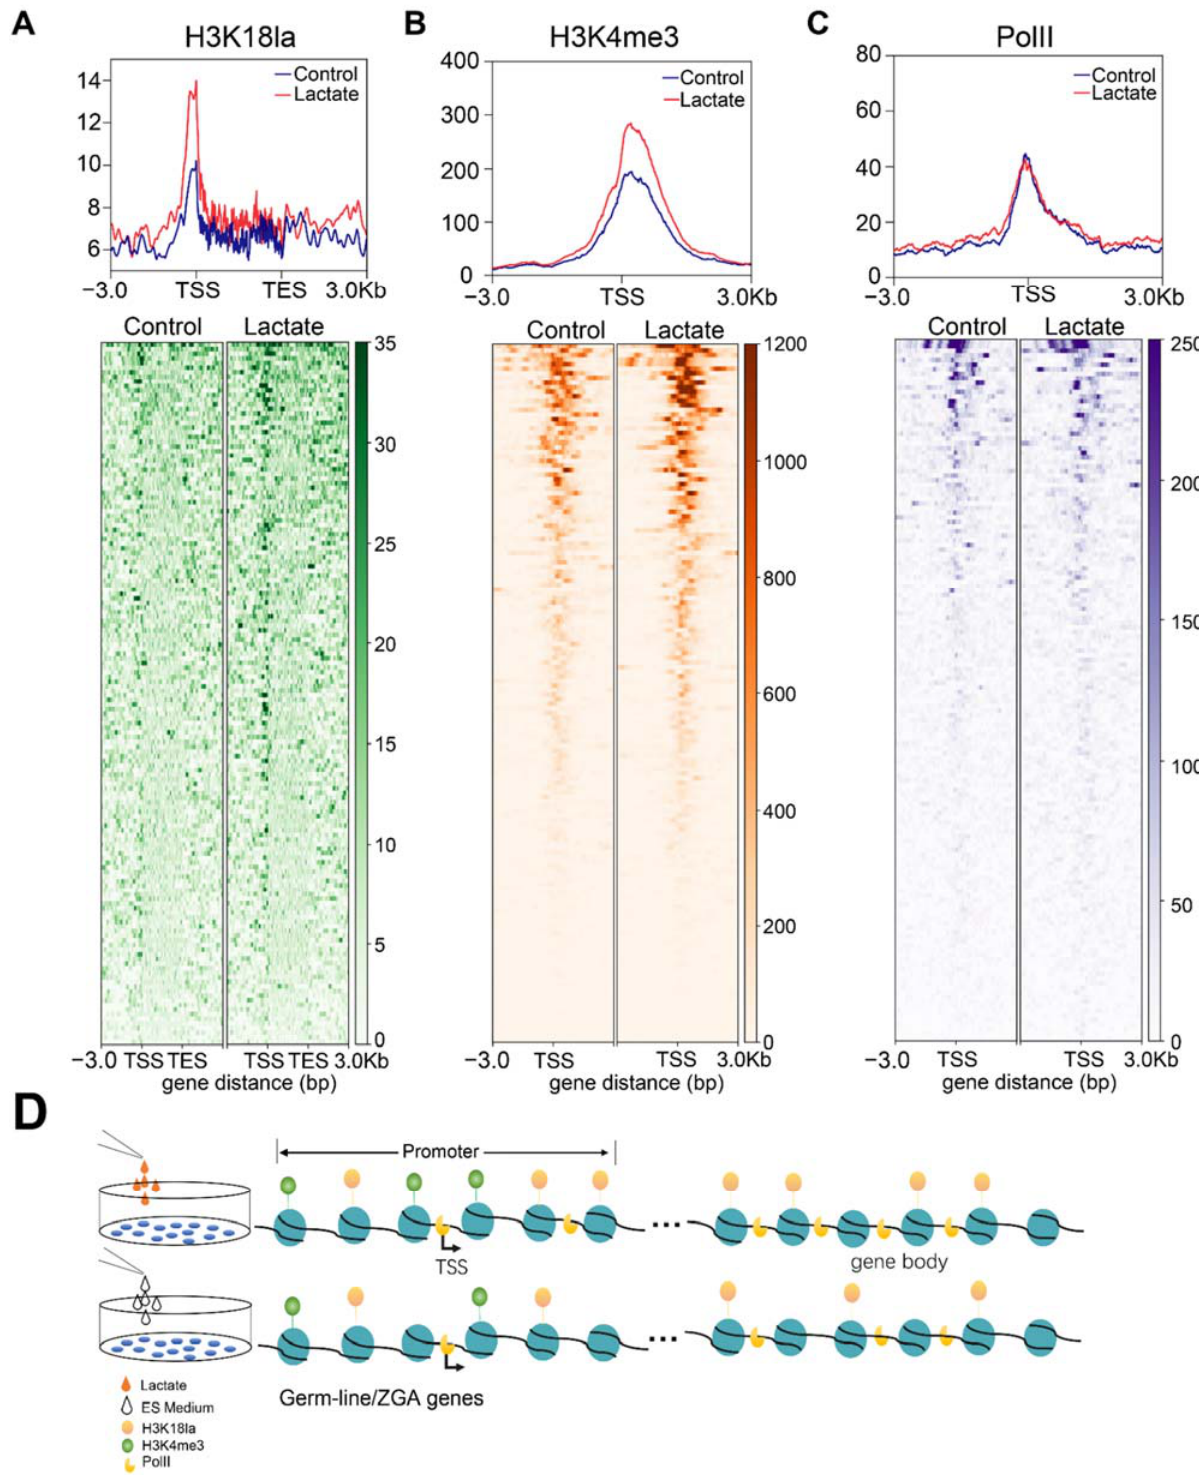
Figure 5. Lactate supplementation facilitated transcriptional elongation through enhanced histone lactylation. ( A – C ) Read density plot of H3K18la ( A ), H3K4me3 ( B ), and RNA PolII ( C ) signals at gene bodies and promoters of upregulated genes ( upper panel ), and corresponding heatmap at gene bodies and promoters (3 kb flanking TSSs) of upregulated genes ( lower panel ). ( D ) Schematic diagram of the mechanism by which lactate promotes expression of germline/ZGA